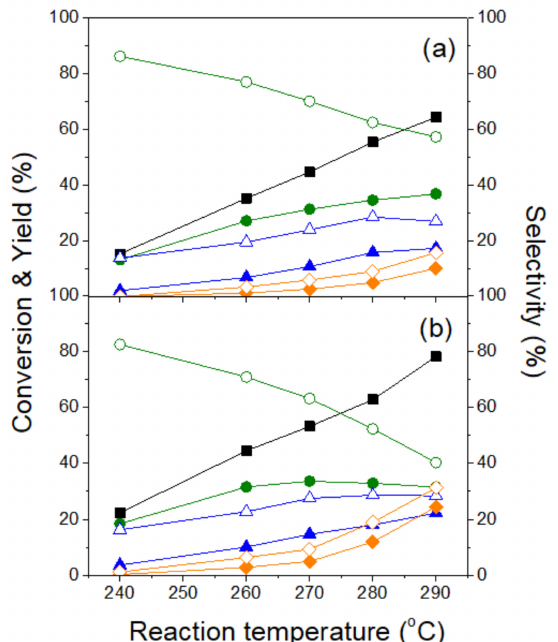
Figure 3. Influence of the reaction temperature on the etherification of glycerol in the presence of ( a ) NaOAc and ( b ) KOAc with NaHSO 4 and KHSO 4 , respectively (- (cid:4) -: conversion of glycerol, - • -: yield of DG, - (cid:78) -: yield of TG, - (cid:7) -: yield of others - -: selectivity of DG, - ∆ -: selectivity of TG, - ♦ -: (cid:35) selectivity of others, the amount of catalyst: 0.5 mol%, the amount of additive: 0.37 mol% and the reaction time: 2 h).